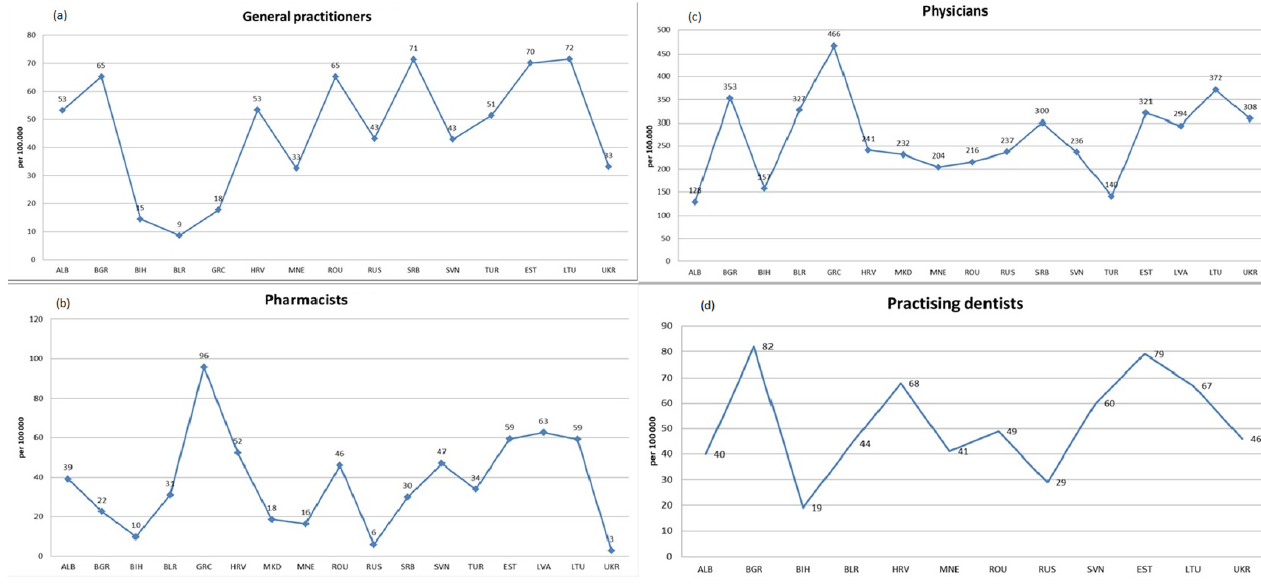
Figure 1. Median values of indicators: ( a ) general practitioners , ( b ) pharmacists , ( c ) physicians , ( d ) practicing dentists , per 100,000 inhabitants. Albania—ALB, Bosnia and Herzegovina—BIH, Bul ‐